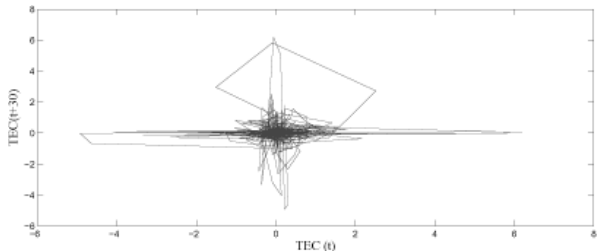
Fig. 5. Delay representation from the phase space reconstruction of the detrended time series.